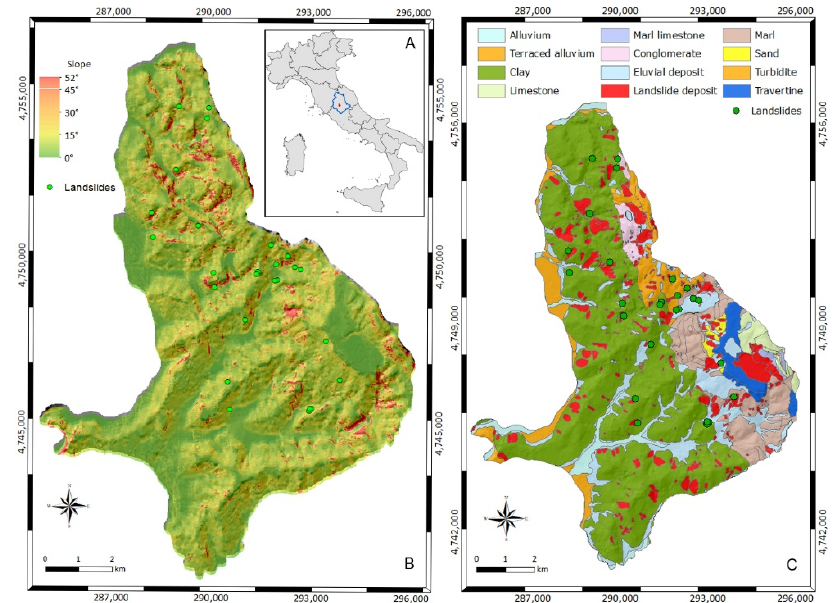
Figure 1. ( A ) Localization of the study area (in red) within the Umbria region (blue borders); ( B ) slope distribution in the area; ( C ) geotechnical classification of soil types according to Fanelli et al., (2016) [55]; the green circles represent the landslides.